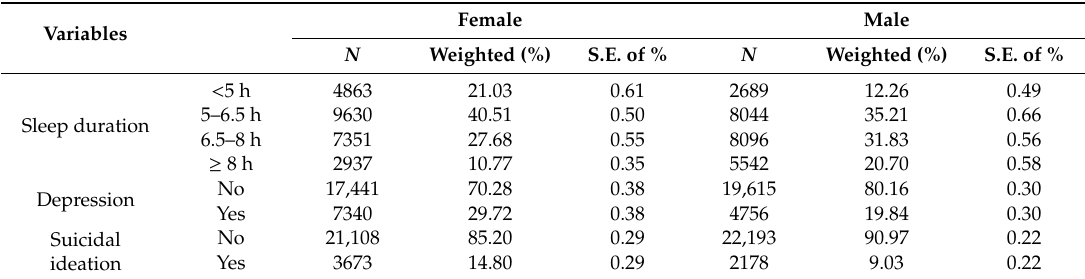
Table 2. Sleep duration and